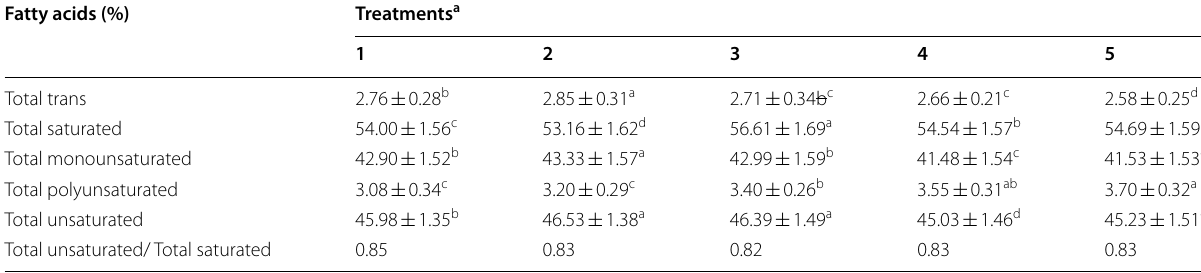
Values are means standard error of three replicates a (1): Cooked control sample, (2): 2% cowpea flour was added cooked sample, (3): 4% cowpea flour was added ± cooked sample, (4): 6% cowpea flour was added cooked sample, (5): 8% cowpea flour was added cooked sample. Means within the same row with diffeerent superscripts are significantly different ( P <